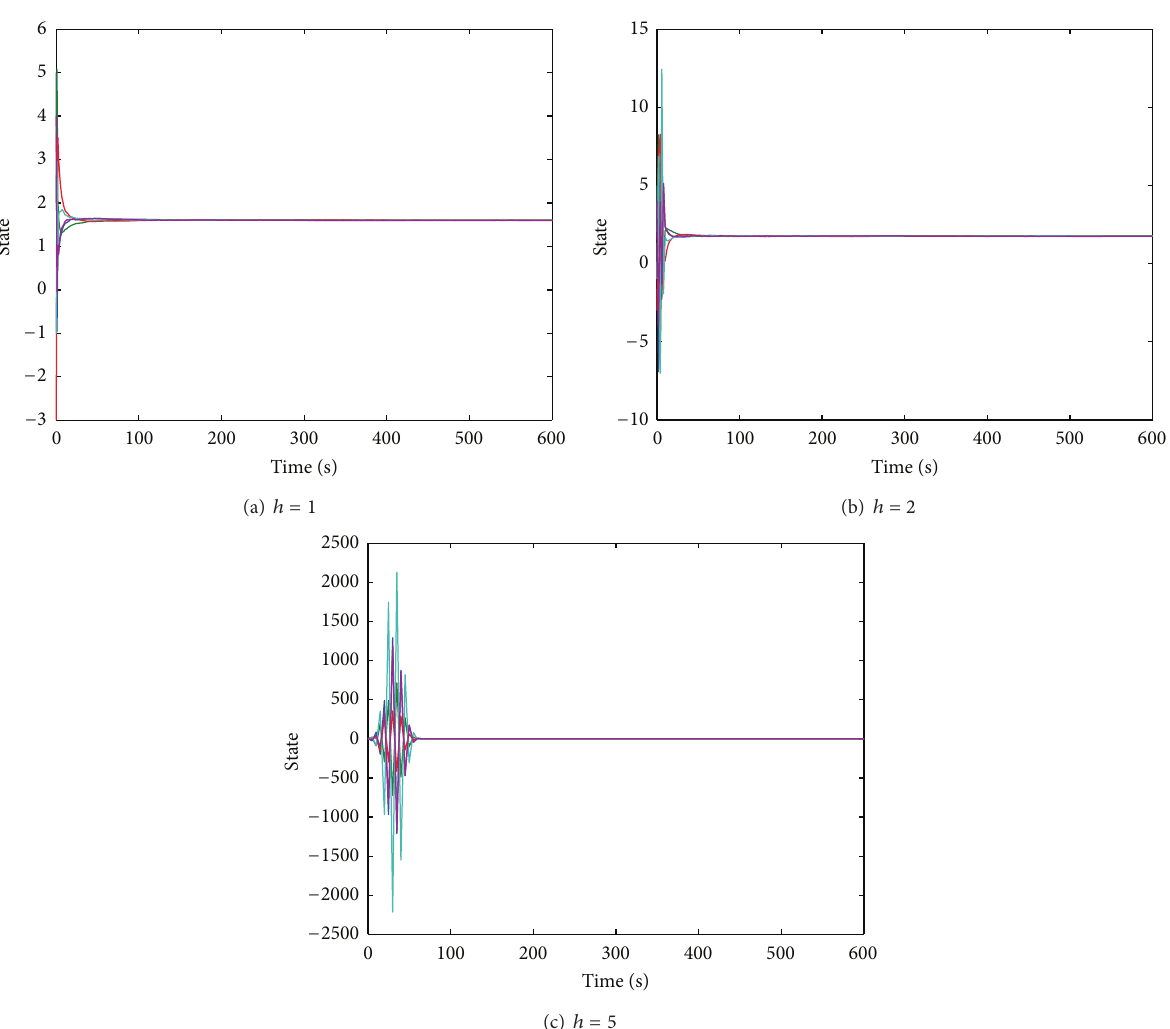
Figure 3: State trajectories under different sampling periods with fixed topology and noisy measurements.